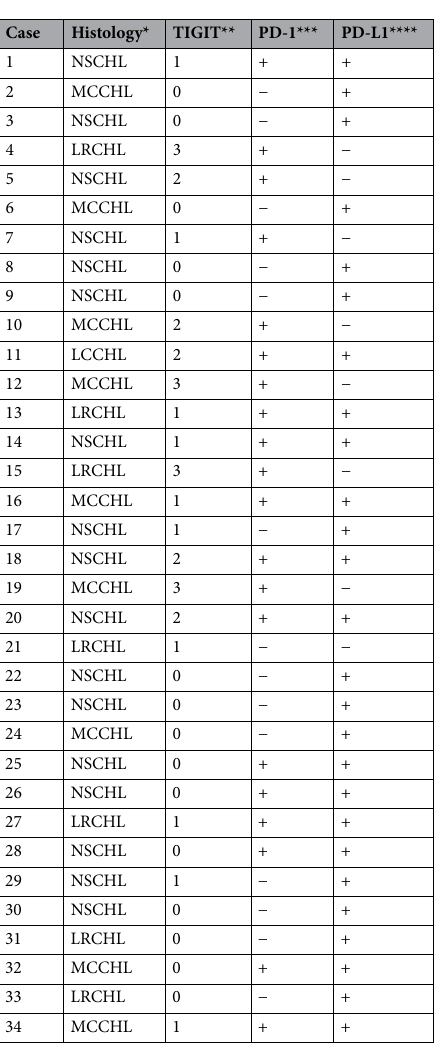
lymphoma, LRCHL lymphocyte rich classic Hodgkin lymphoma. **TIGIT expression was reported and graded from 0 to 3 using the proposed scoring system. ***PD-1 assessment was performed on